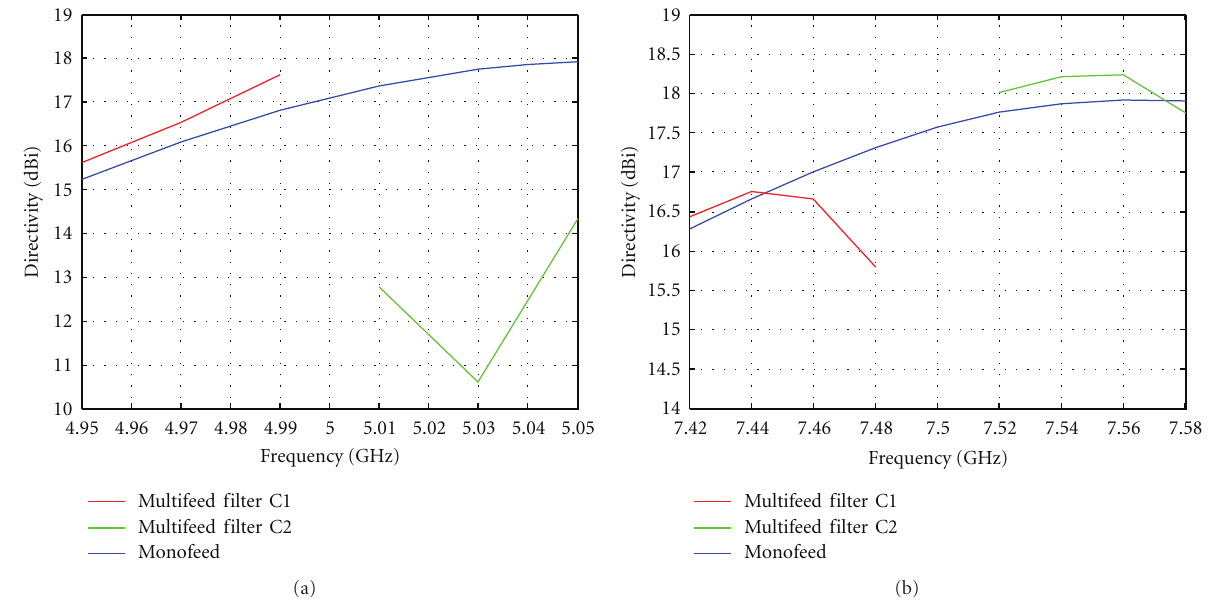
Figure 16: Directivity of the multifeed EBG antenna connected to filters inside both channels, compared to the ones of the monofeed antenna at f L (a) and f H